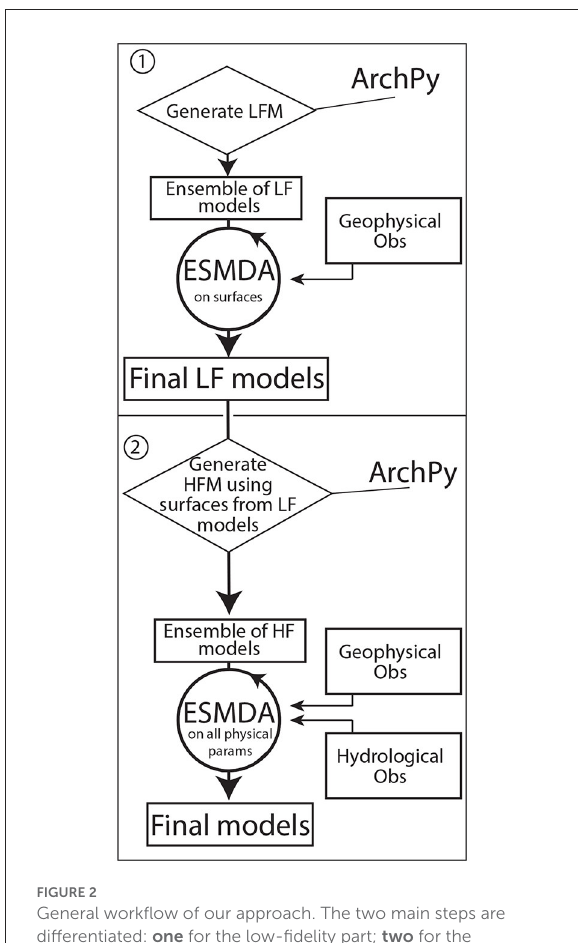
FIGURE2 General workflow of our approach. The two main steps are differentiated: one for the low-fidelity part; two for the high-fidelity